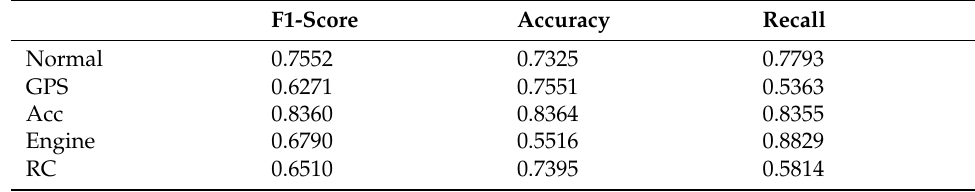
Table 16. Results of IMU data.